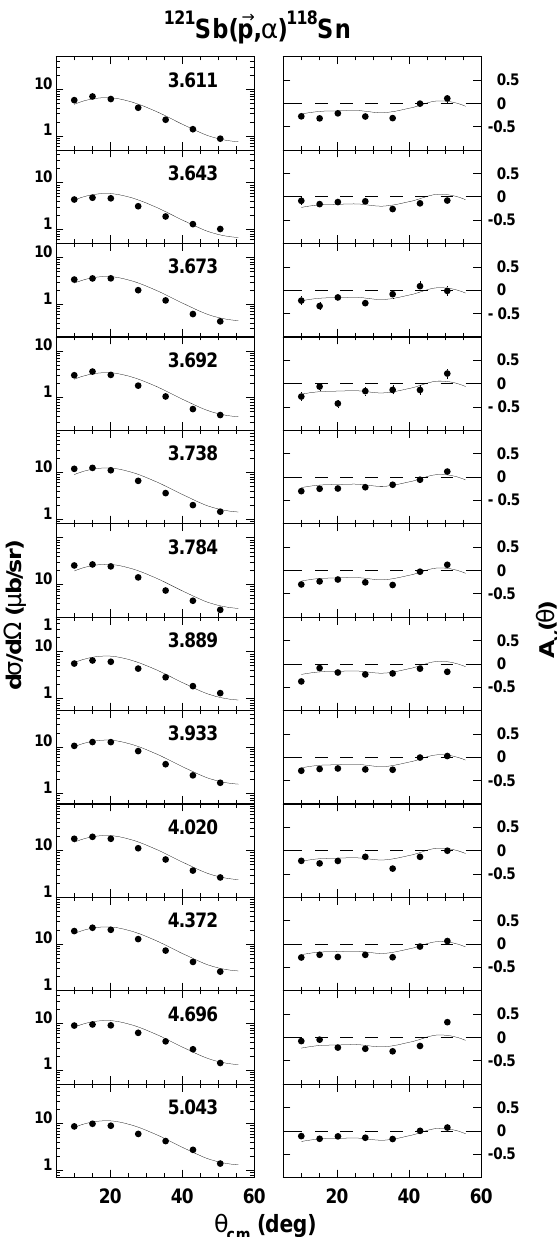
Fig. 4. Angular distributions of cross sections and asymmetries for some of the 23 positive parity daughter states of 118 Sn ho- mologous to the G.S. 9 / 2 + 117 In parent state. Dots refer to the experimental values of the daughter states and solid lines to the experimental values of the parent state.